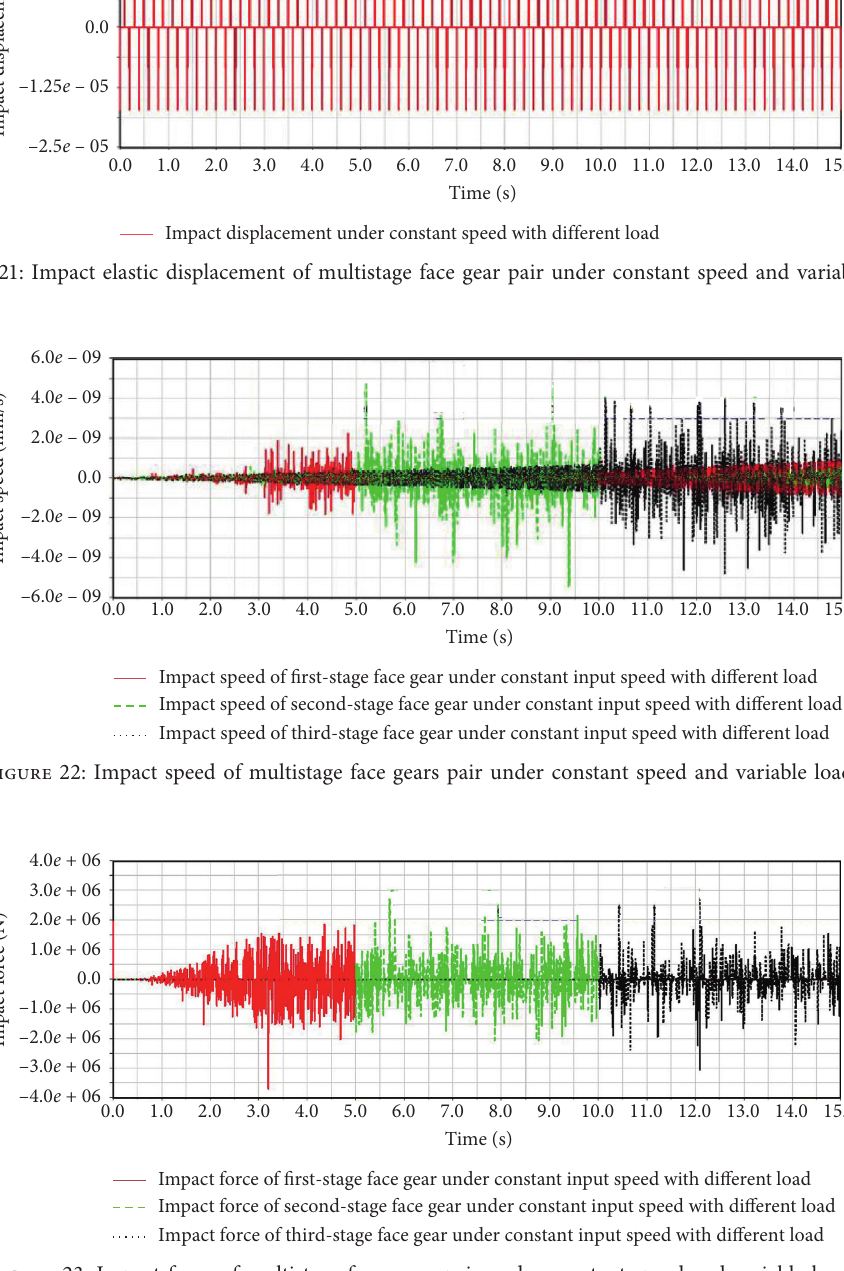
Figure 23: Impact force of multistage face gears pair under constant speed and variable load.